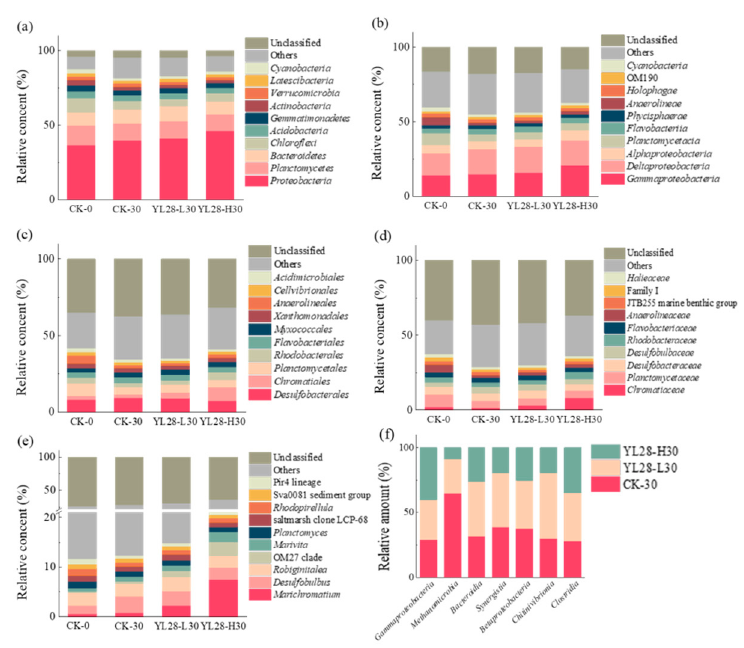
Figure 3. The distribution and composition of bacterial community each classification level. ( a ) Predominant species to relative average abundance statistics at phylum level; ( b ) predominant species to relative average abundance statistics at class level; ( c ) predominant species to relative average abundance statistics at order level; ( d ) predominant species to relative average abundance statistics at family level; ( e ) predominant species to relative average abundance statistics at genus level. Significant difference: p < 0.05; ( f ) the relative average abundance changes of significant dif- ference species ( p < 0.05) at class level.